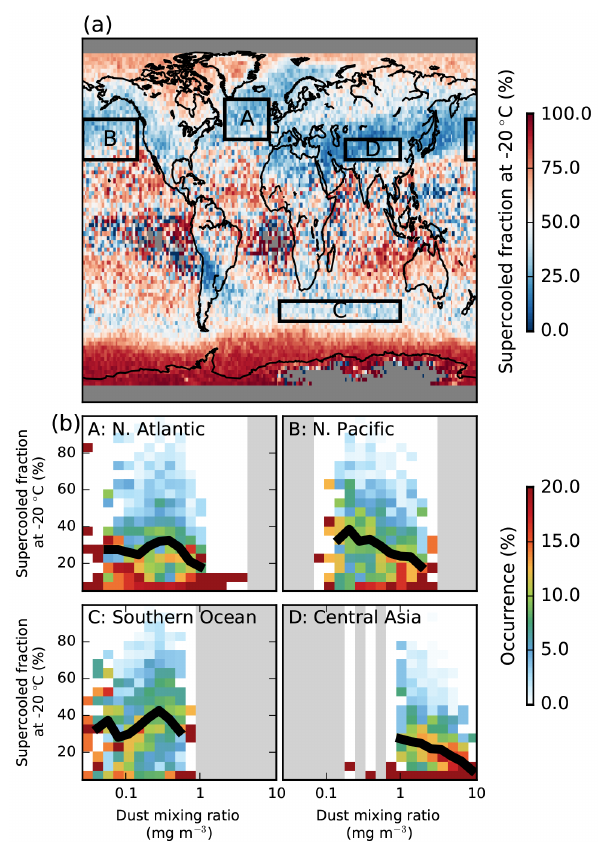
Figure 7. (a) The DARDAR supercooled fraction at − 20 ◦ C, de- fined as the fraction of the DARDAR cloud top phase retrievals be- tween − 17 . 5 and − 22 . 5 ◦ C from 2006 and 2013 that are classed as liquid. (b) The conditional probability of observing a daily mean supercooled fraction, given a specified MACC dust mixing ratio for the regions specified in (a) . The black line shows the mean super- cooled fraction for each aerosol